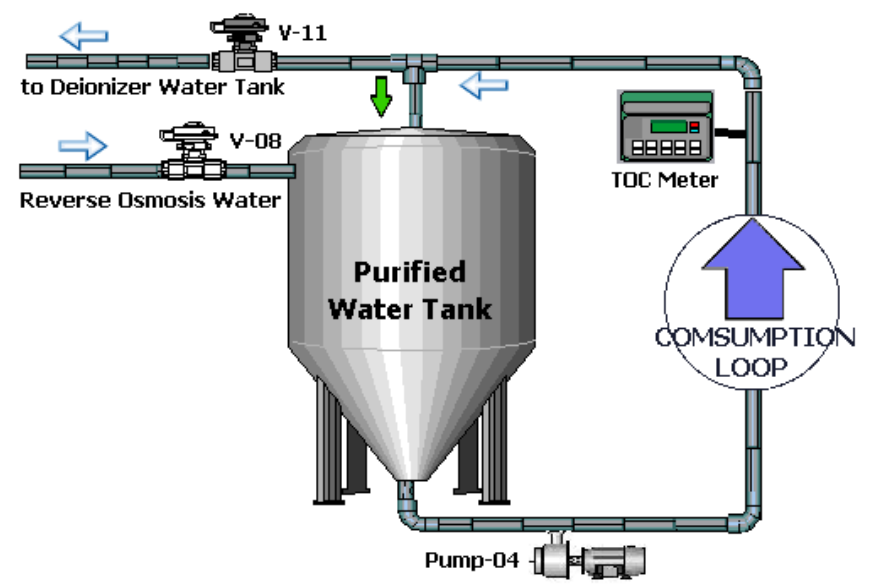
Figure 5. System: storage, distribution and